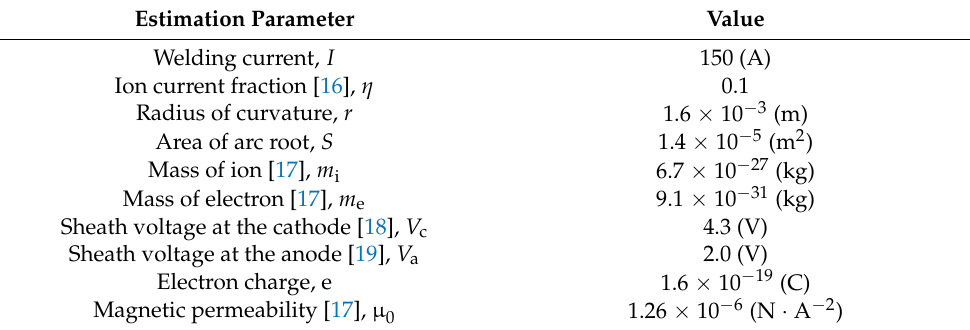
Table 2. Estimation